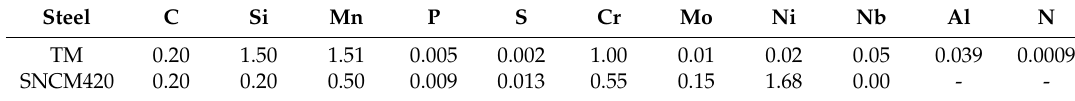
Table 1. Chemical composition [mass%] of the steels used.